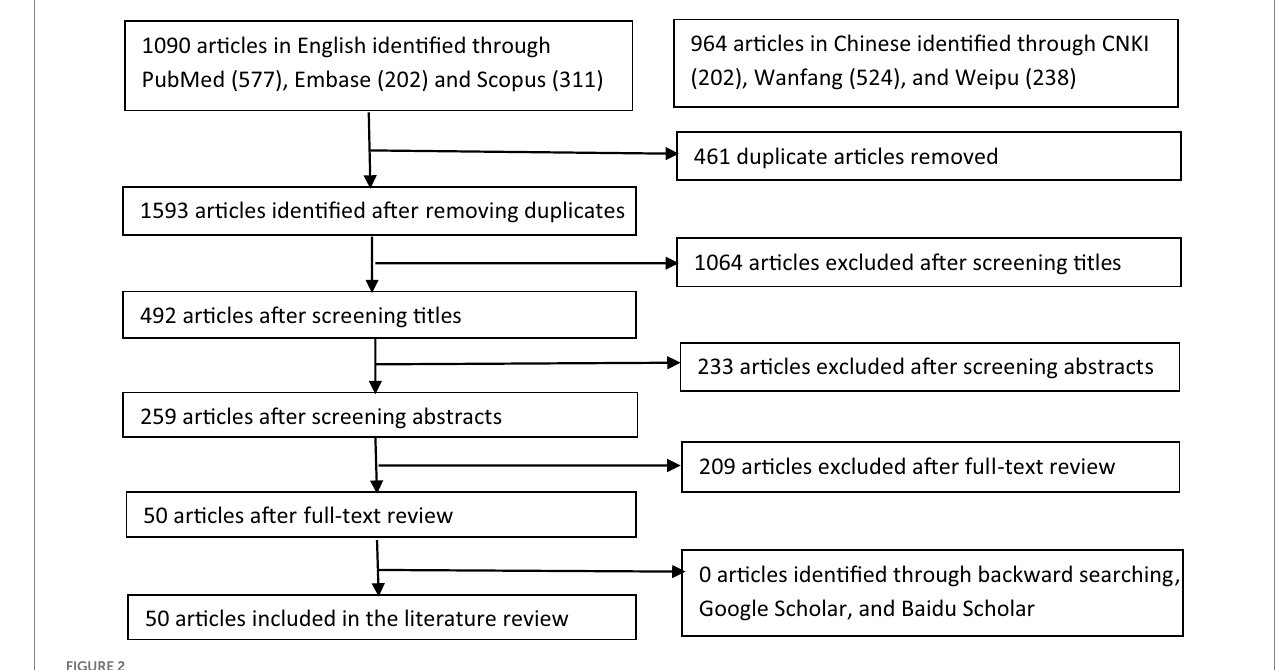
FIGURE 2 Flow chart of literature search